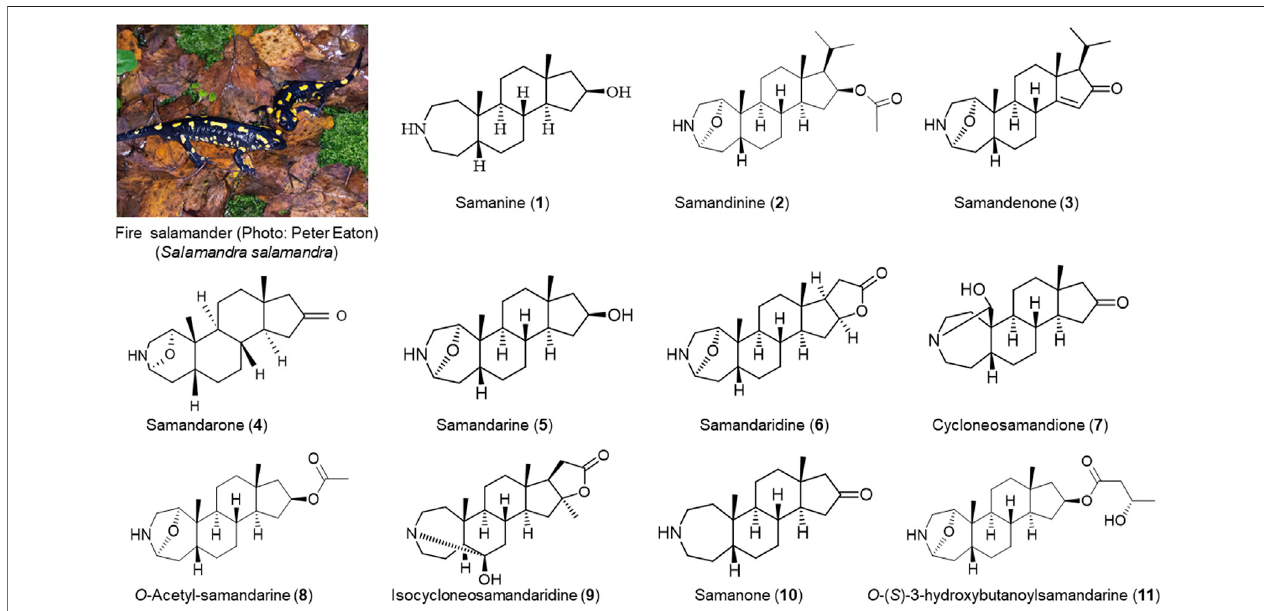
FIGURE 1 | Alkaloids identi fi ed in the skin secretion of fi re salamander ( Salamandra salamandra ). (1) : (Habermehl, 1967; Habermehl and Haaf, 1968; Habermehl andPreusser,1969;Habermehl,1971); (2) (HabermehlandVogel,1969); (3 , 4 , 5 , 6 ,and 7) :(Habermehl,1964,Habermehl,1967;HabermehlandHaaf,1968;Habermehl and Preusser, 1969; Habermehl, 1971); (8) (Habermehl, 1964); (9) (Daly et al., 2005); (10 , 11) (Knepper et al., 2019).